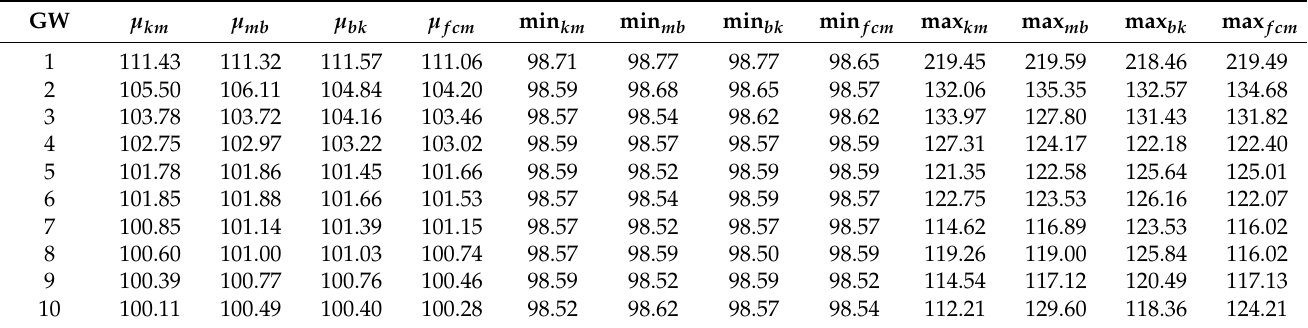
Table 5. Energy metrics for Scenario 1 by algorithm and number of